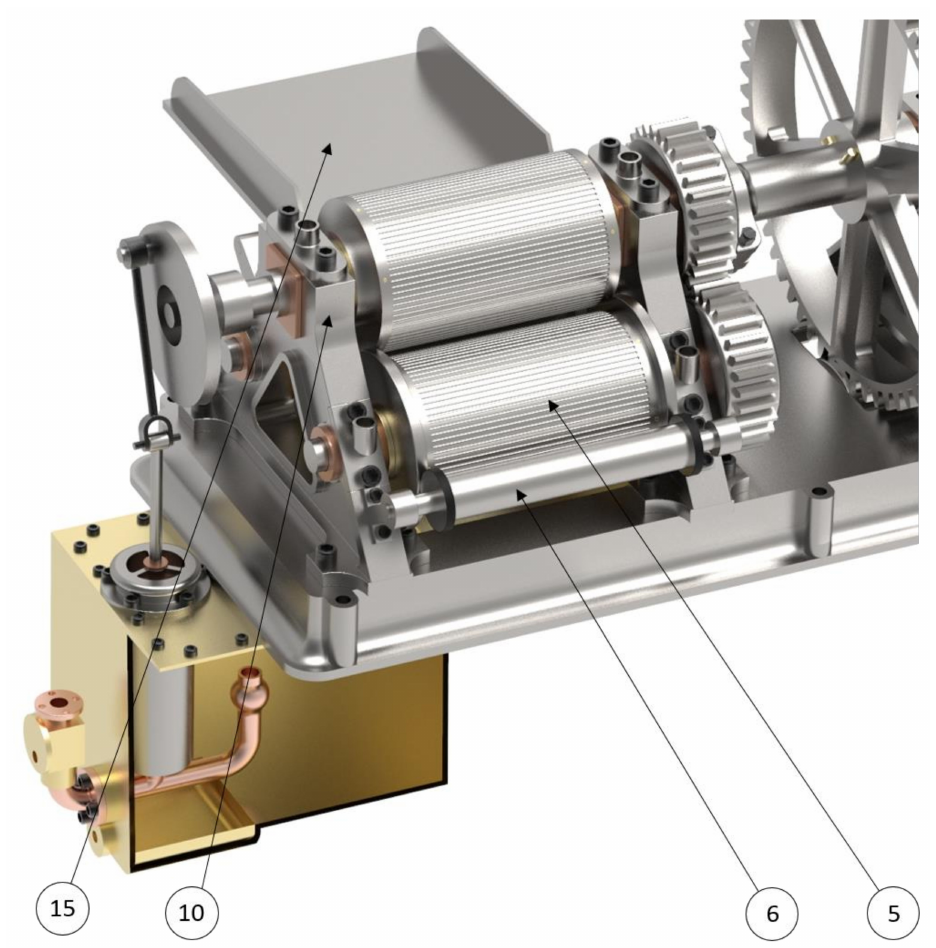
Figure 8. View of the mill cylinders and juice collecting tank with